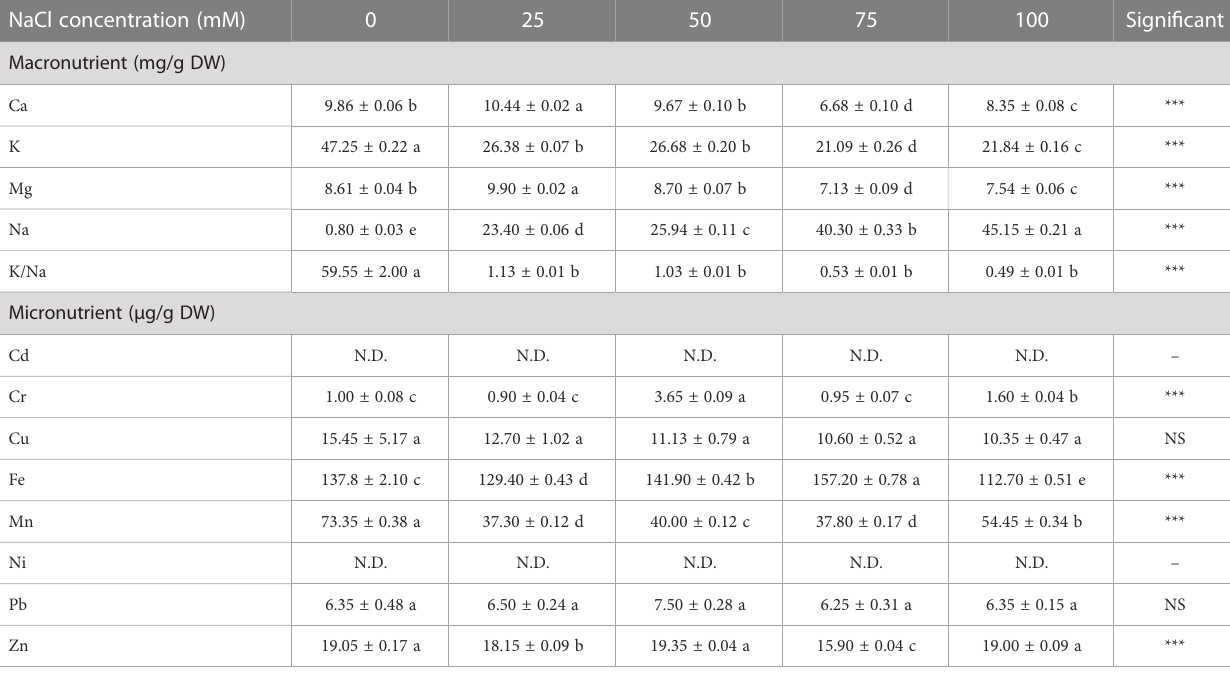
TABLE 2 Mineral ions and Na + content of Limonium tetragonum under different NaCl concentrations. NaCl concentration